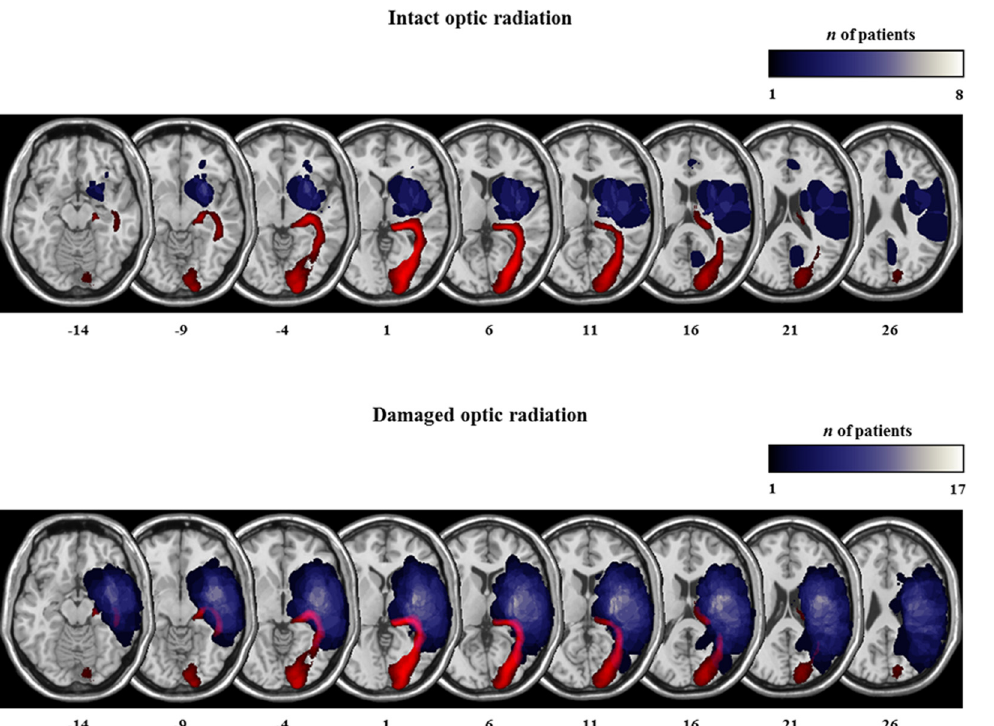
Fig 3. Lesion mapping. Lesion location and overlap map for neglect patients with intact and damaged right optic radiation. Lesion overlap plotted onto the ch2.nii.gz template of the MNI brain. Lesions are plotted on axial slices oriented according to neurological convention. The slices of the brain are depicted in 5mm ascending steps. The Z position of each axial slice in the MNI Talairach stereotaxic space is presented at the bottom of the figures. The number of patients with damage involving a specific region is colour-coded according to the legend. The optic radiation is based on a recently published DTI atlas (18), and is represented in red